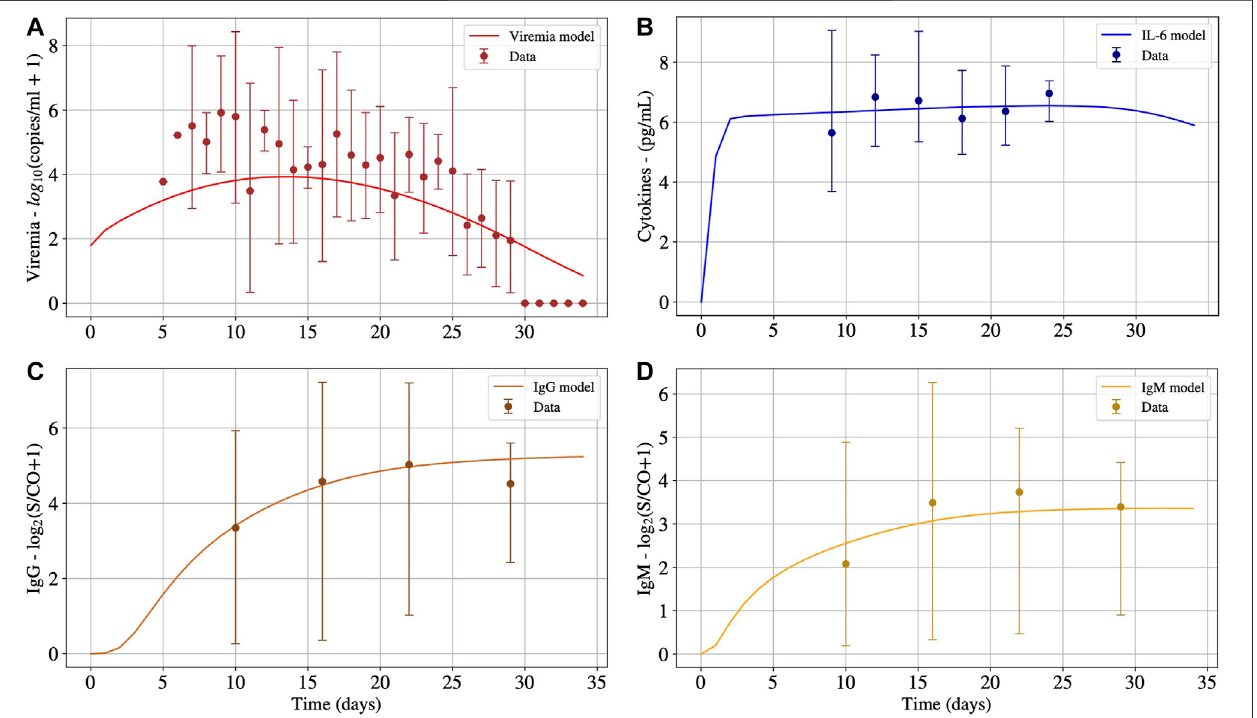
FIGURE 2 | The numerical results presented in Panels A, B, C and D represent the solution of Eqs 1 , 15 , 14 and 13 , respectively. These numerical solutions were fi tted for patients without CRS. Interval used for initial conditions and parameters are given in Table 2 .